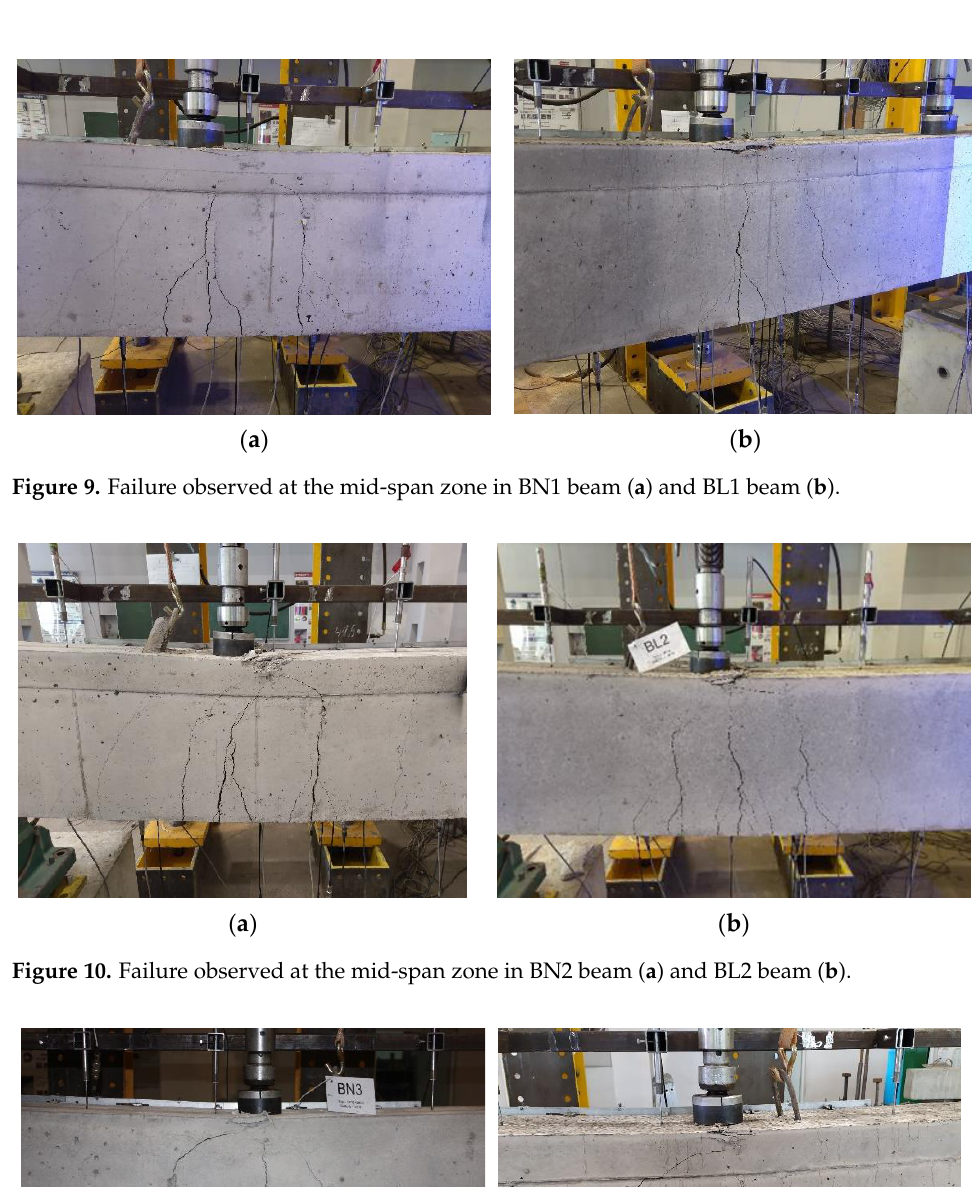
Materials 2021 , 14 , x FOR PEER REVIEW 10 of 19 Figure 8. Crack propagation in BN3 and BL3 beams. Note: numerals given in figures indicate the applied load F (in kN).